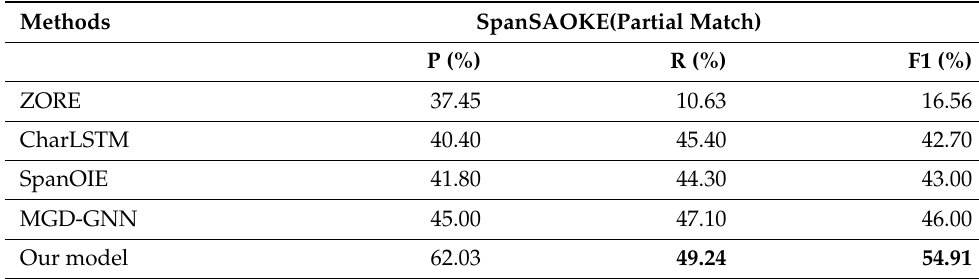
Table 4. The results of each method on SpanSAOKE. Some experimental results are directly quoted from previous comparative